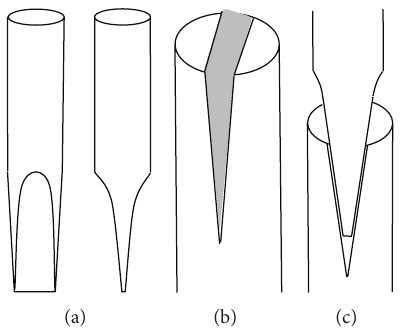
Figure 1: Operation flow of sapling cleft grafting by hand.